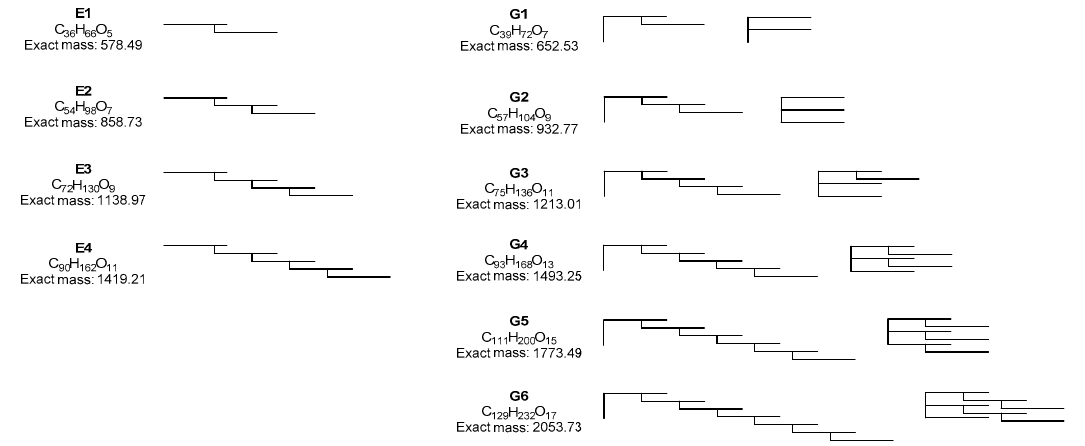
Figure 2. Structures of estolides (E) and glycerides (G). Within each glyceride group (G1–G6) the different isomers have identical chemical formulas and masses (not all isomers are shown). Table 2. MALDI MS analysis of product mixtures from lipase screening, showing presence (+) and